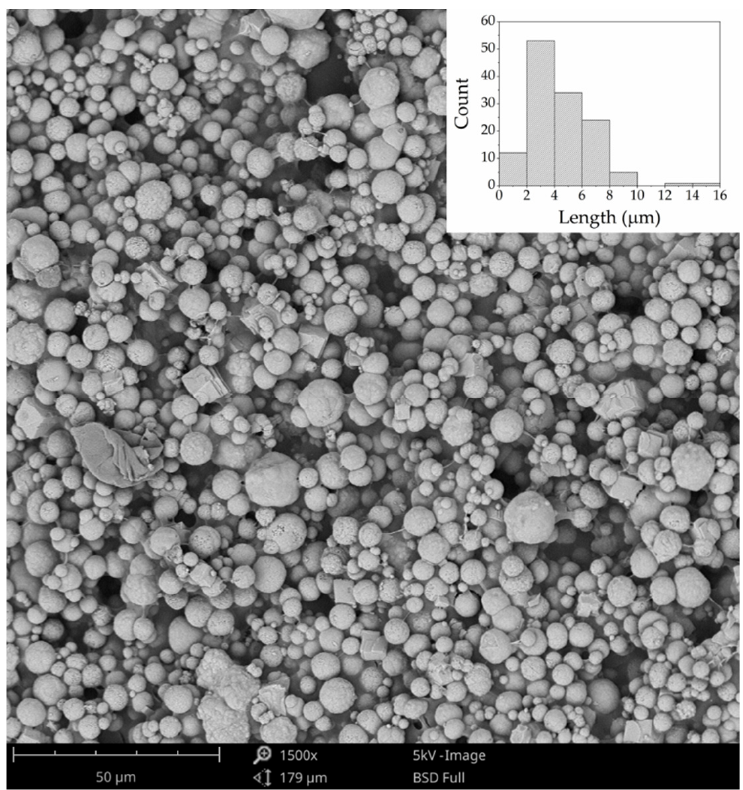
Figure 5. SEM image of MC ‐ ASC deposited inside the mat. The histogram inset represents the size distribution of MC ‐ ASC beads.